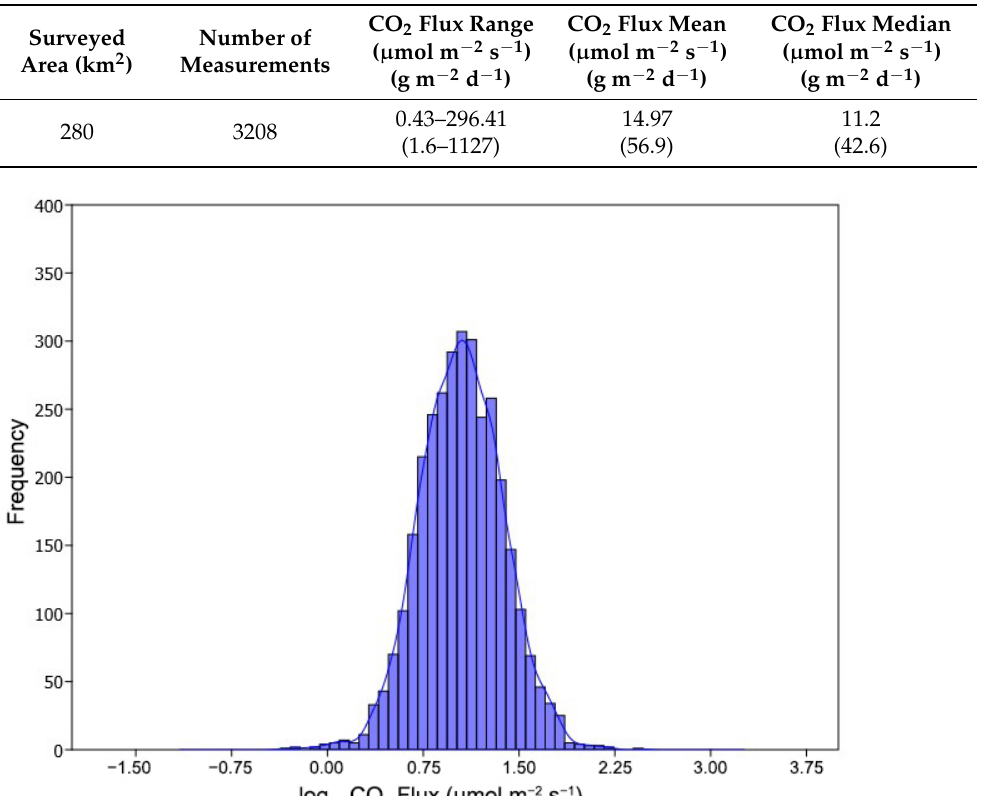
Table 1. Summary statistics of the entire soil CO 2 flux dataset in the Mt. Amiata region.